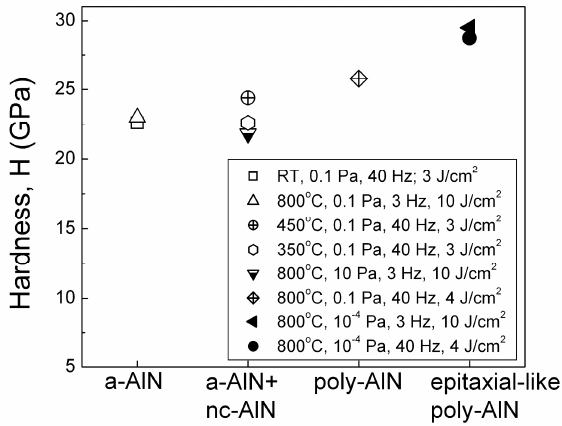
Figure 7. Variation of the hardness values with the film structure obtained at different PLD conditions, given in the inset.